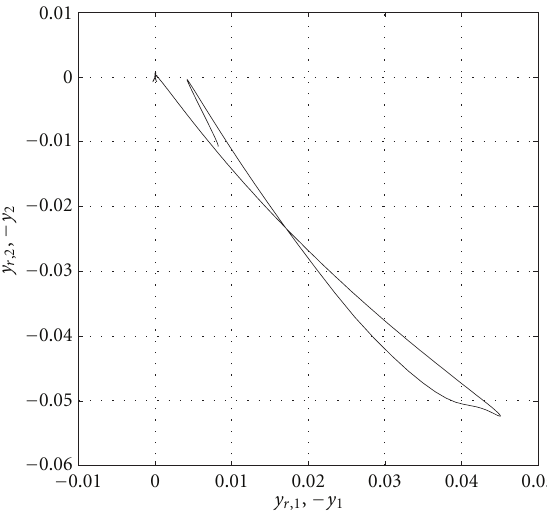
Figure 3: Tracking error in the robot workspace.